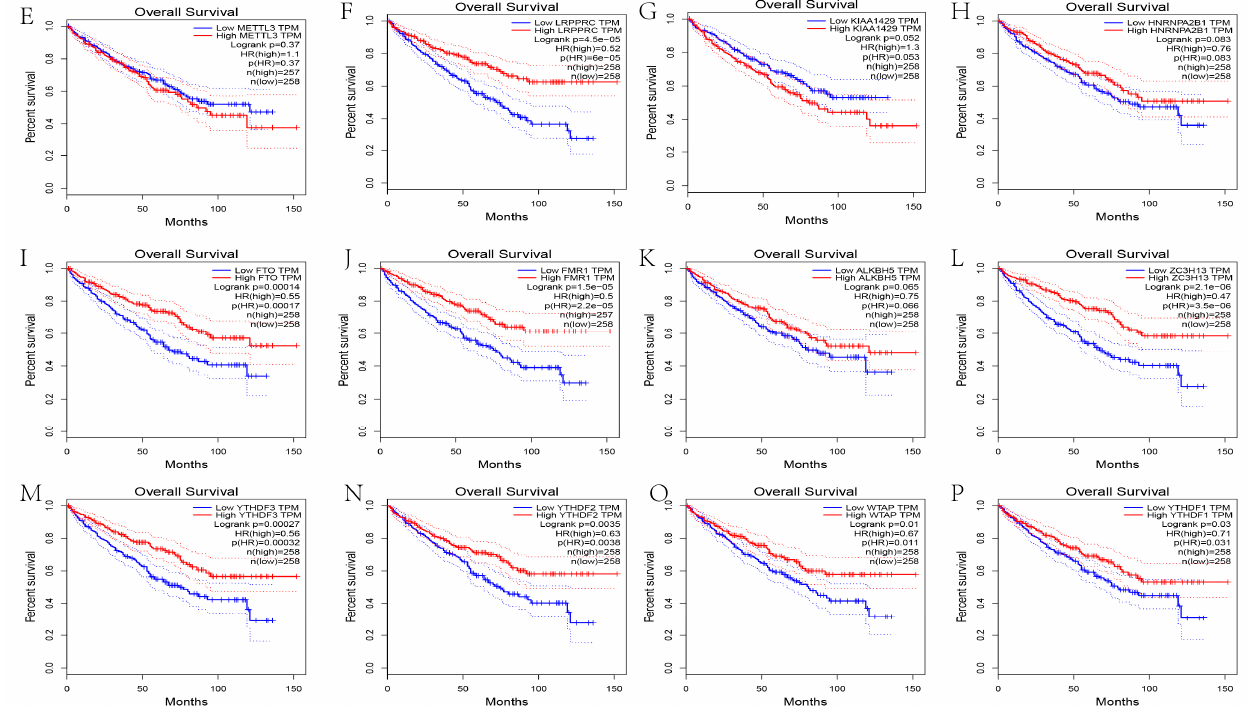
Figure 13. OS analysis of m6A-related genes using GEPIA. Kaplan–Meier plots demonstrate that high expression of YTHDC1 ( A ), YTHDC2 ( B ), RBM15 ( C ), METTL14 ( D ), METTL3 ( E ), LRPPRC ( F ), KIAA1429 ( G ); HNRNPA2B1 ( H ); FTO ( I ), FMR1 ( J ), ALKBH5 ( K ); ZC3H13 ( L ), YTHDF3 ( M ), YTHDF2 ( N ), WTAP ( O ), YTHDF1 ( P ) was associated with increased OS. Table 2. Correlation analysis between hub genes and m6A-related genes. Correlation analysis was performed using the TIMER2.0 website. The numbers represent the strength of the correlation. Red indicates a positive correlation. Blue indicates a negative correlation. Gray color means nonsignificant. The expression of CASR, CAT, ERBB2, and P2RY8 is positively related to the expression of m6A-related genes. The expression of TIMP1 is negatively related to the expression of m6A-related genes. Correlation Analysis between Hub Genes and m6A Related Genes